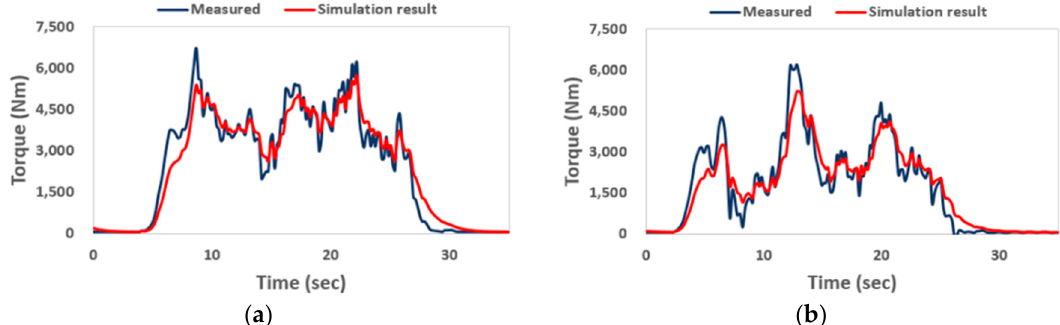
Figure 7. Comparison of averaged axle torque of ( a ) left and ( b ) right sides of the tractor for measured and simulated results at a ground speed of 10 km/h in off-road